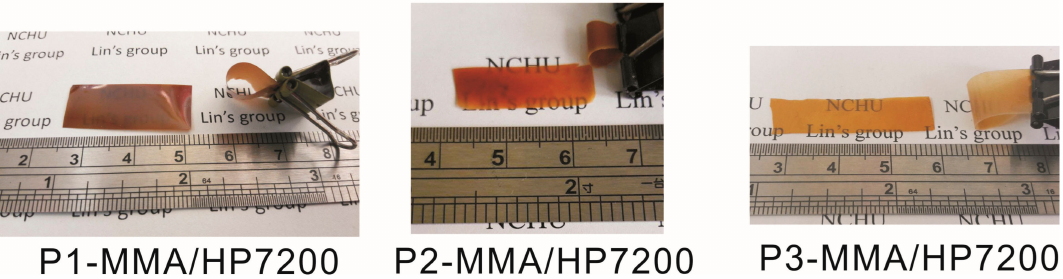
Figure 6. Photos of